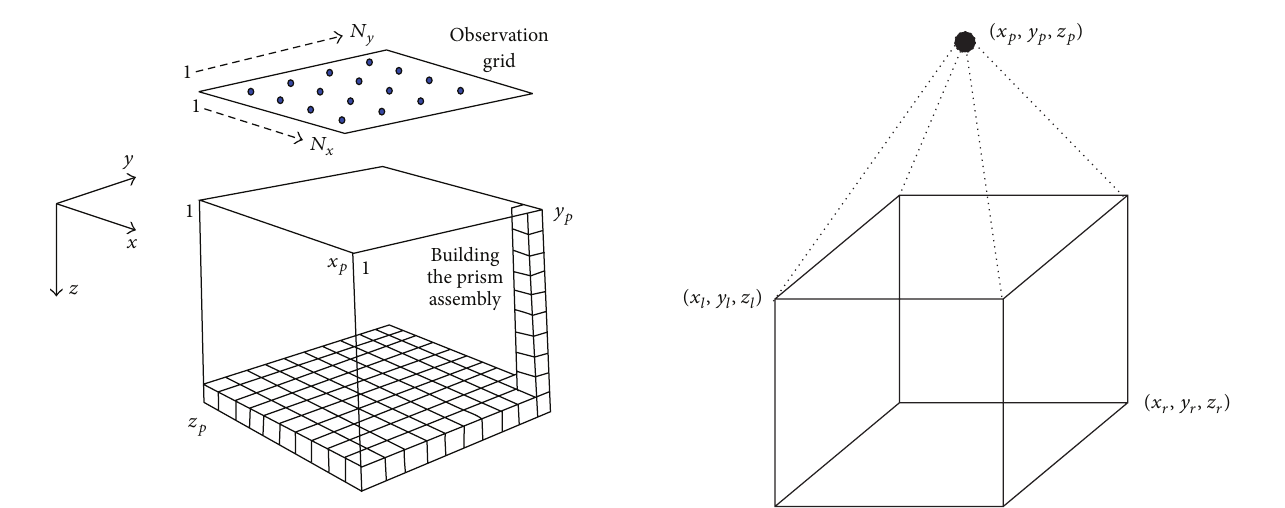
Figure 2: Illustration of the calculation of the anomaly produced by a prism with respect to an observation point.